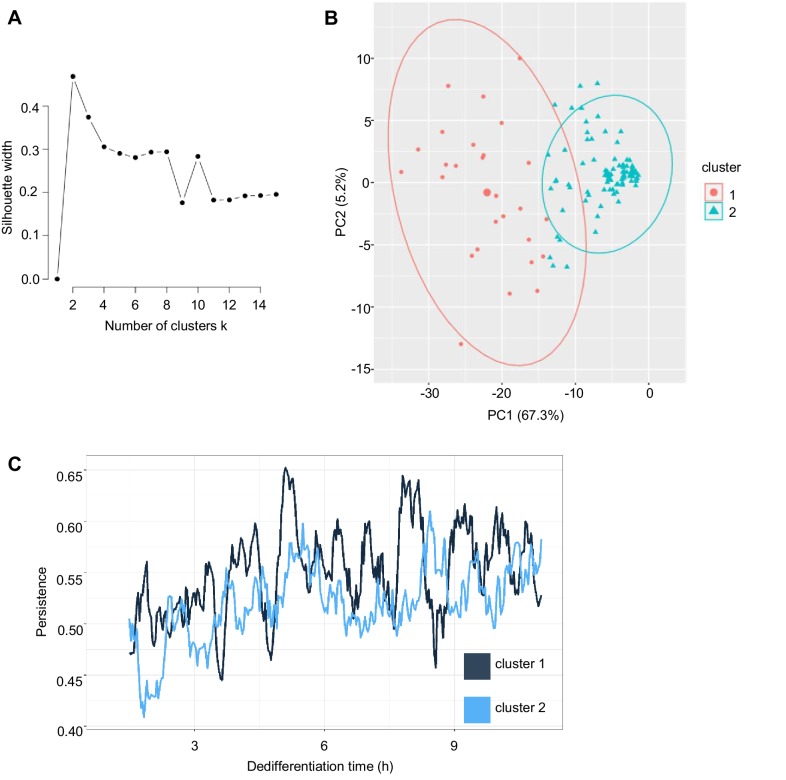
Heterogeneity in cell motility during dedifferentiation.(A) Defining the number of motility clusters using silhouette criteria. Average silhouette width for different numbers of clusters in k-means clustering of cell speed profiles. Two clusters were chosen on the basis of maximum silhouette width. (B) Principal component analysis of cell speed profiles highlighting cell clusters. Small circles and triangles show individual cells, large circle and triangle indicate cluster centre. (C) Persistence of motility during the first 11 hr of dedifferentiation, for cells clustered on the basis of speed; cluster 1 (28 cells), cluster 2 (92 cells). Persistence defined as accumulated distance/Euclidean distance and was calculated for a sliding window of 30 min for each cell. Data pooled from four independent experiments.